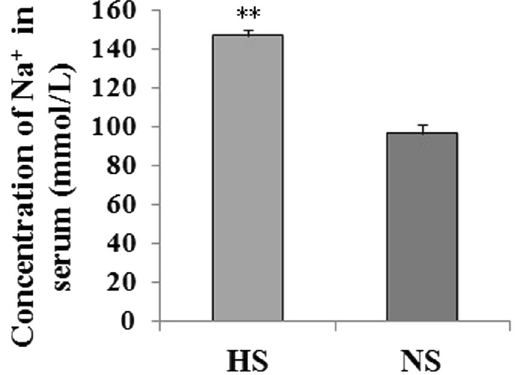
Figure 6. Sodium ion concentration in serum from mice fed HS and NS diets. The sodium ion concentration in serum was significantly higher (P < 0.01) in HS mice. Data are means ± SEM, n = 6, ** P < 0.01.